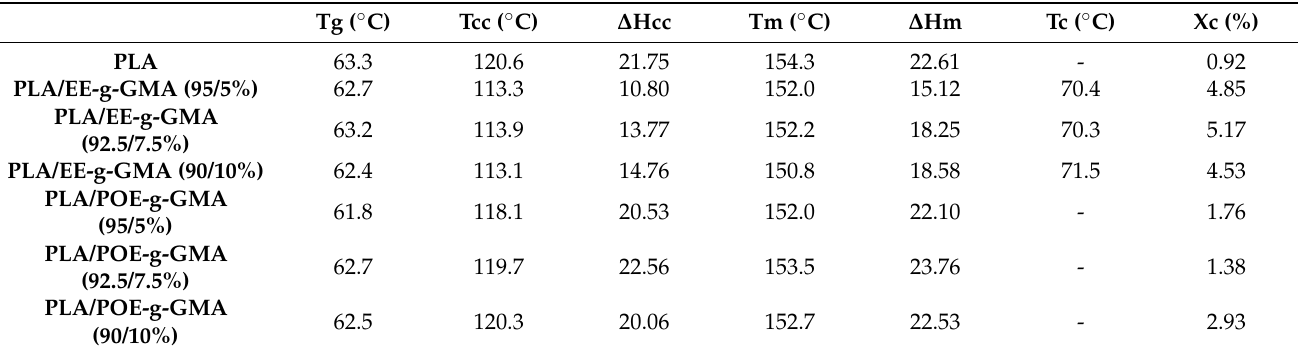
Table 2. Data obtained in the DSC of the compositions.